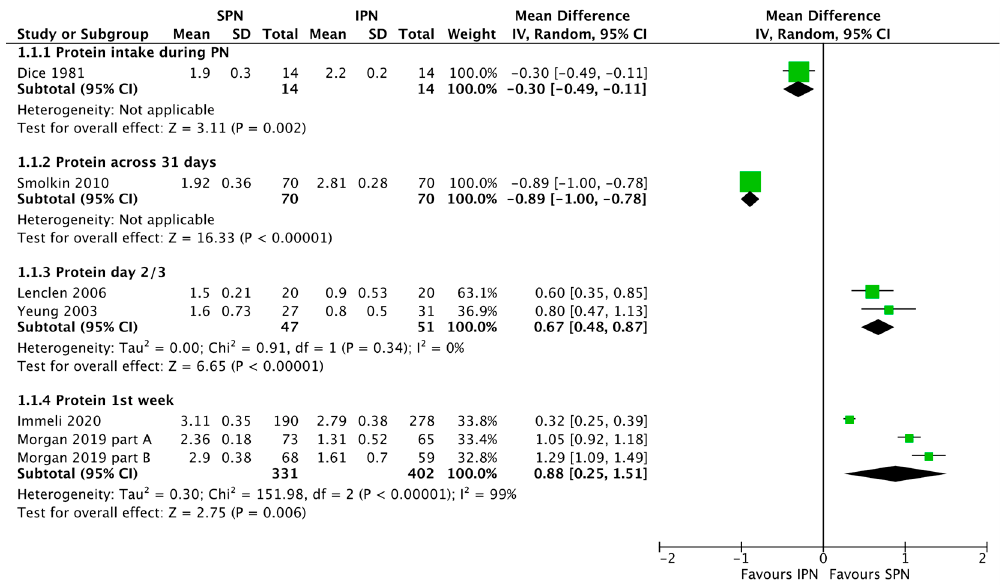
Figure 2. Forest plot on the effect of standardized parenteral nutrition (SPN) vs. individualized parenteral nutrition (IPN) on protein intake. Green squares represent individual studies, diamonds represent subgroup analyses.